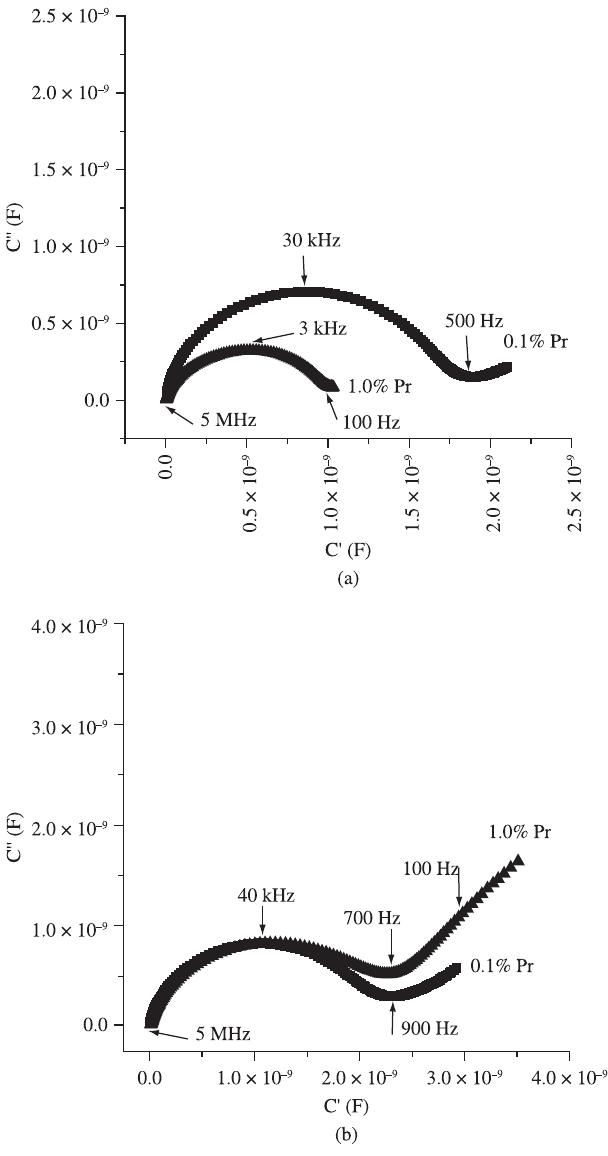
Figure 5. Complex capacitance behavior of the ZPC varistors systems with different content of Pr